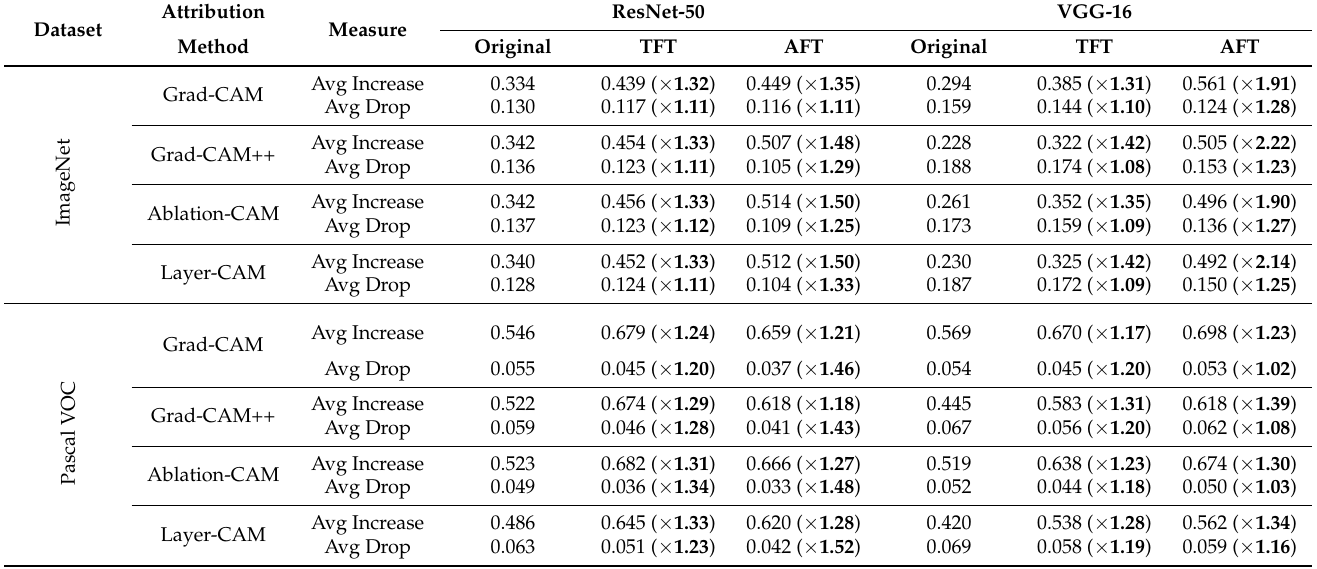
Table 3. Comparison of the quality of attribution maps: the original attribution maps (Original), the original attribution maps optimized by the threshold fine-tuning (TFT), and the attribution maps generated with the CNN optimized by the activation fine-tuning (AFT) without any threshold fine-tuning. The numbers in boldfaces indicate performance improvements over the original cases.